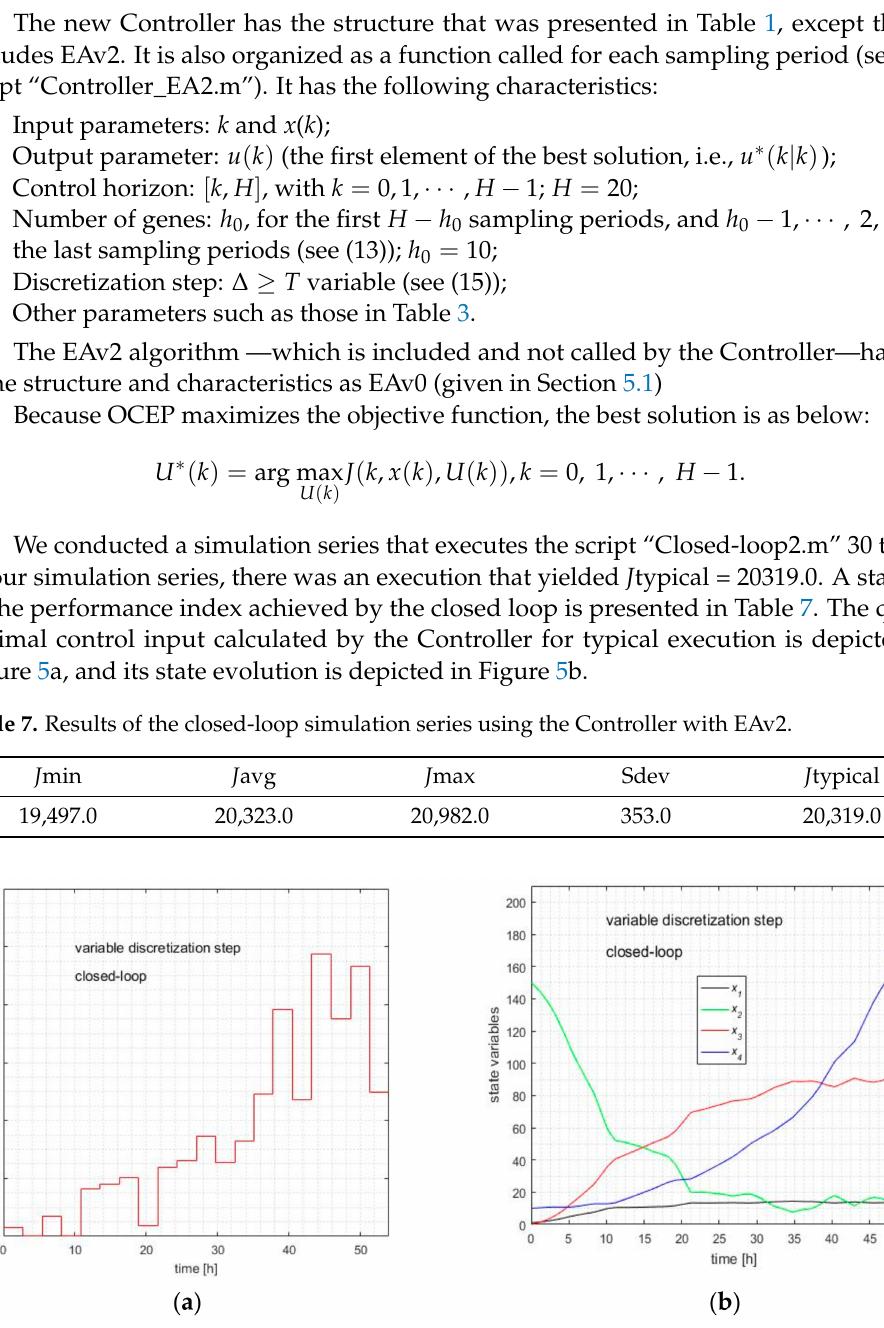
Figure 5. The typical solution given by the Controller using an evolutionary algorithm with improved computational complexity. ( a ) The quasi-optimal solution given by the Controller using EA with a variable discretization step. ( b ) State evolution in closed